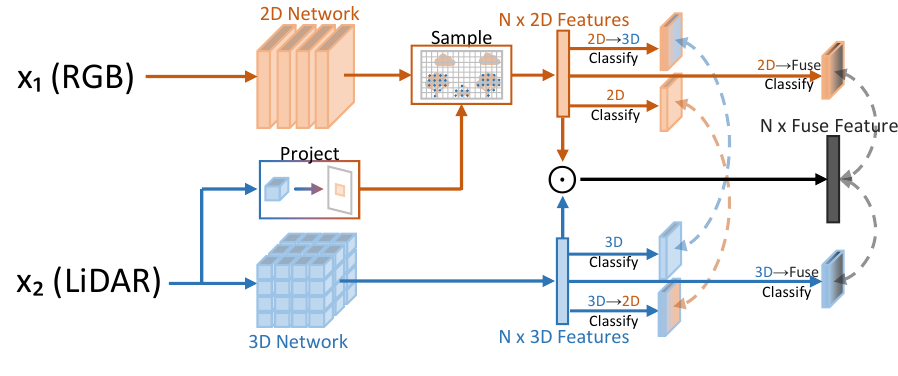
Figure 15. xMUDA [121] 2D/3D